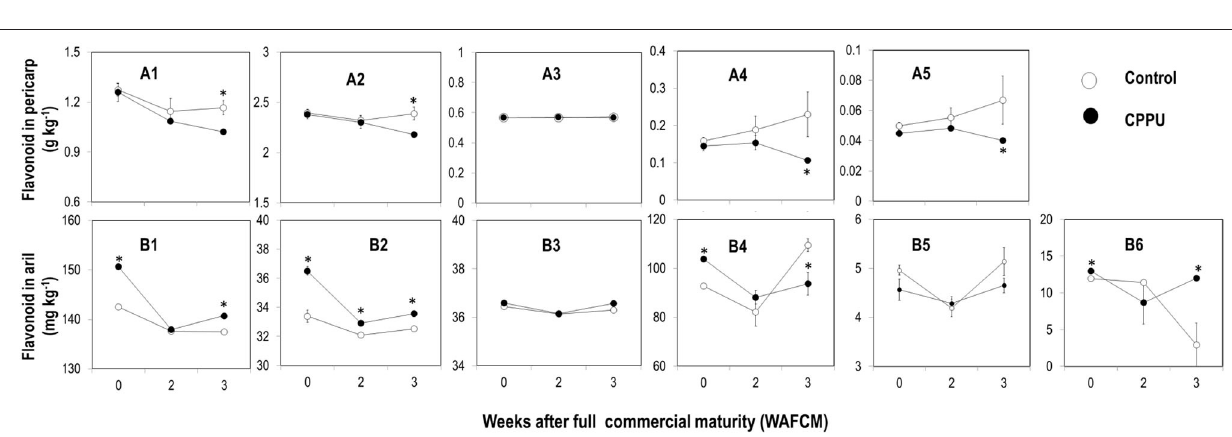
FIGURE 5 | Effect of preharvest application of CPPU on changes in some non-anthocyanin flavonoids including epicatechin (A1,B1) , gallocatechin (A2,B2) , epicatechin gallate (A3,B3) , proanthocyanidin B2 (A4,B4) , keampfenol-3-o-rutincide (A5,B5) , and proanthocyanidin B1 (B6) in the pericarp (A series) and the aril (B series) of ripe “Feizixiao” litchi fruit on tree. Vertical bar at each data point stands for standard error ( n = 5). *Indicates significant difference between CPPU treatment and the control at p < 0.05, Student’s t